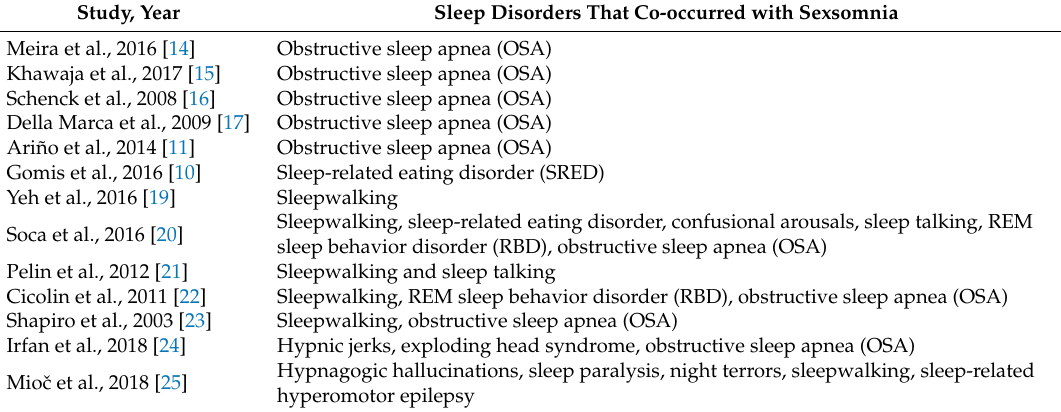
Table 1. Data extraction of selected